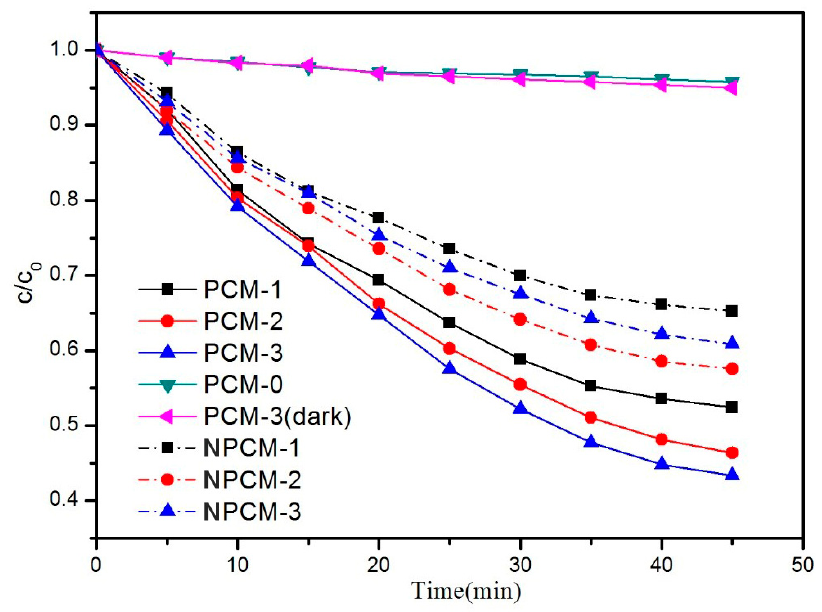
Figure 8. The degradation rate of acetone.